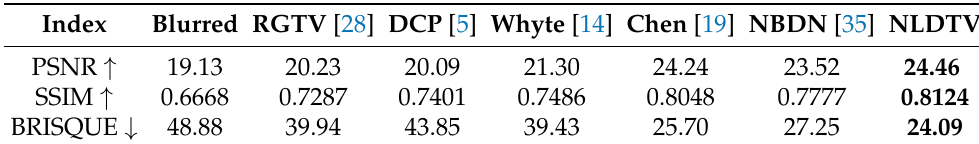
Table 1. Quantitative comparison on synthetic dataset Exdark [42] with motion blur. The reference- based indexes of PSNR (: dB) and SSIM and non-reference-based index BRISQUE of different images are presented, and the last row presents the average (Ave.) indexes of restored results of different methods.